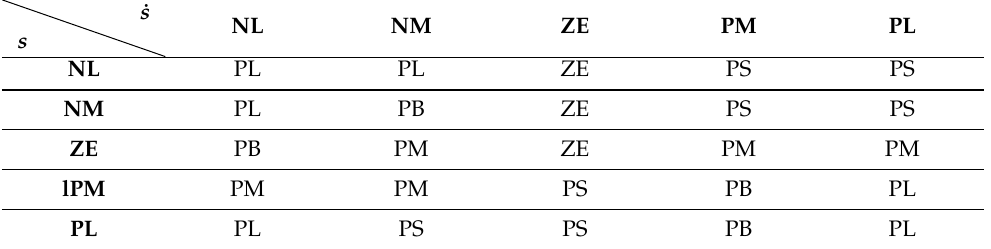
Table 4. Fuzzy logic rules for K f .